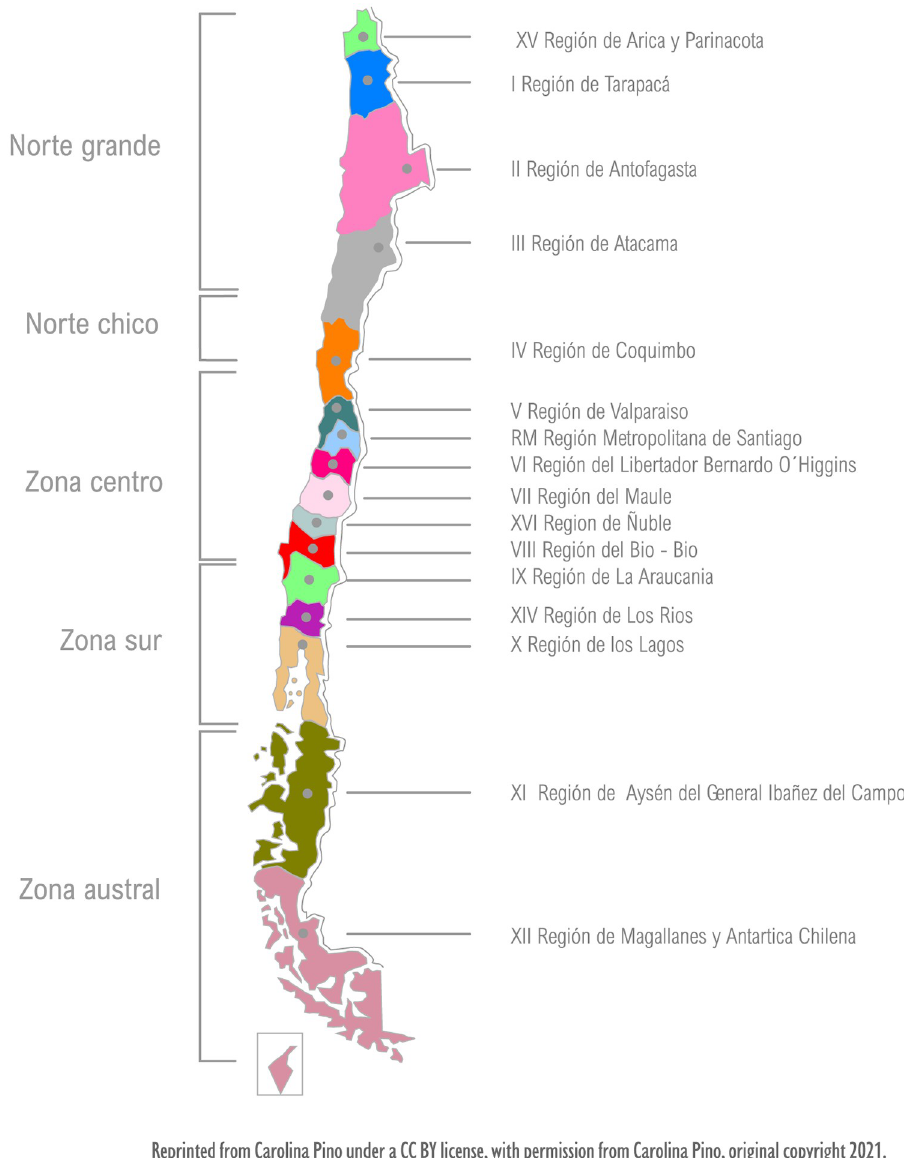
Fig 1. Political map of Chile showing its administrative and geographical